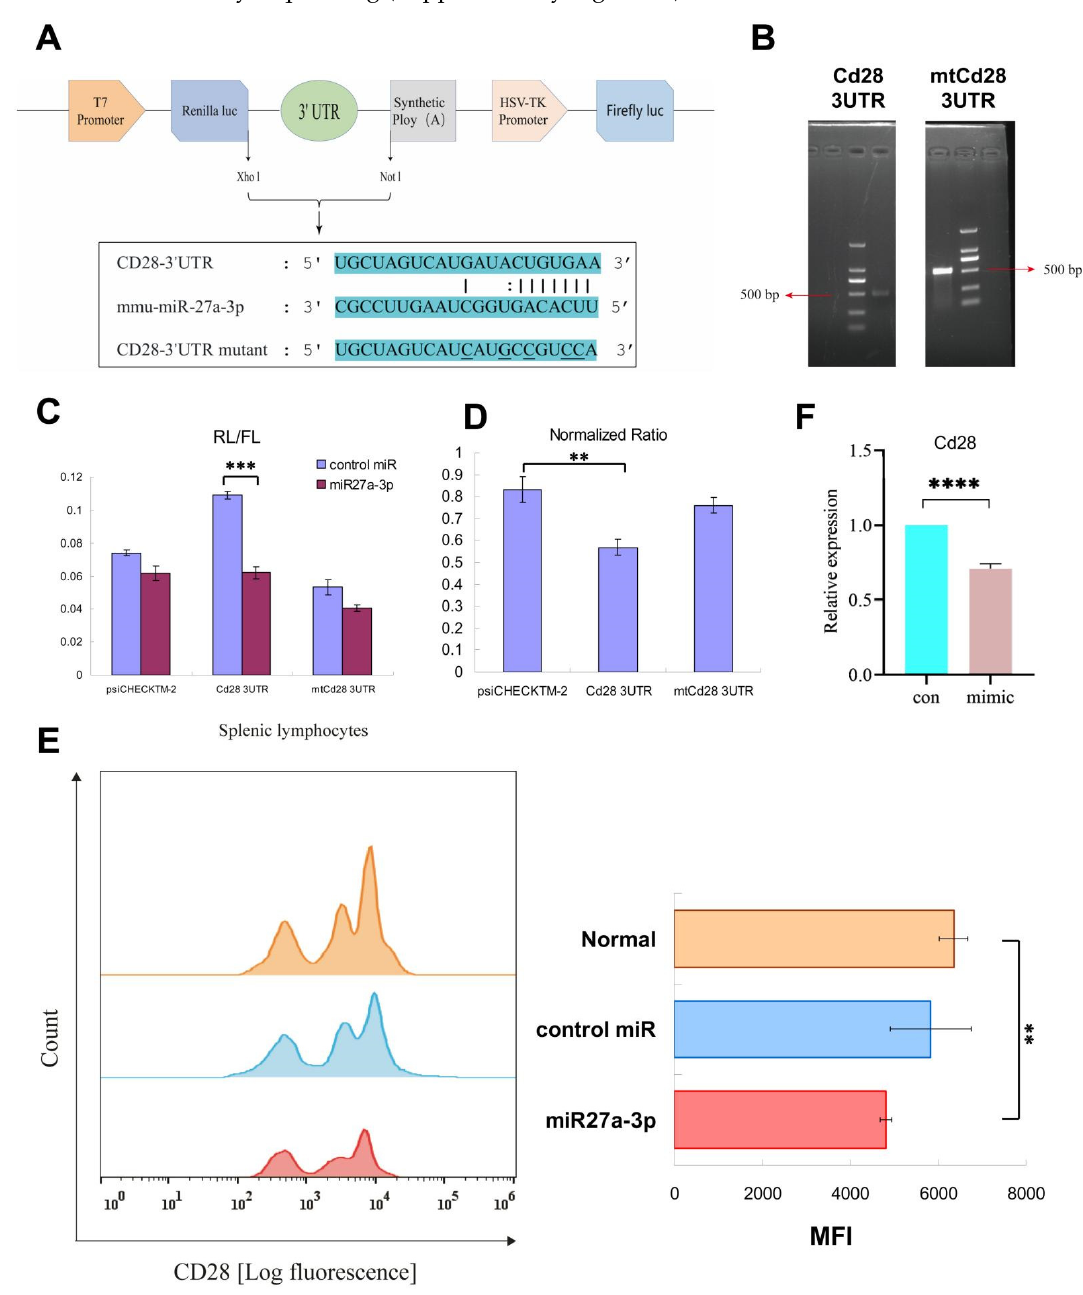
Figure 5. Regulation of Cd28 gene expression by mmu-miRNA-27a-3p . ( A ) A miRNA-27a-3p binding site with the Cd28 3 ′ UTR was predicted using starBase 3.0 and a mutant binding site was designed as a control. ( B ) Amplification of the Cd28 3 ′ UTR and the preparation of mutant Cd28 3 ′ UTR by overlap PCR. ( C ) The RL/FL ratio of each group. ( D ) The normalized ratio of each group. ( E ) Flow cytometric analysis of the expression of Cd28 on splenic lymphocytes from C57 mice transfected